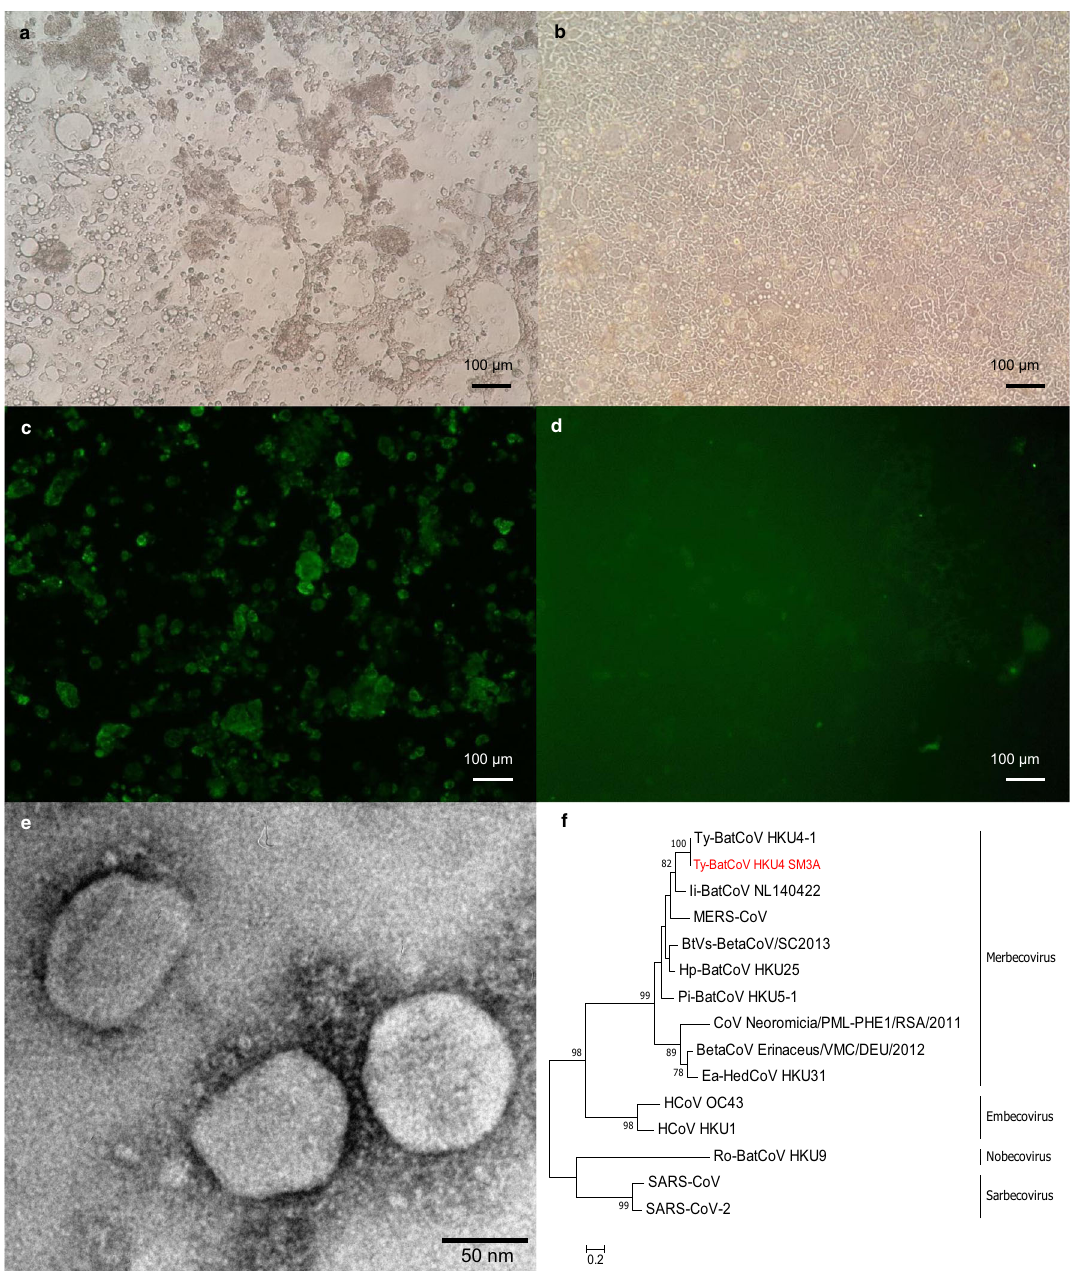
Fig. 1 Isolation of Ty -BatCoV HKU4 using Caco-2 cells. a Caco-2 cells infected with Ty -BatCoV HKU4 SM3A showing CPE with rounding up of fused and granulated cells progressively detaching from the monolayer forming masses of dead cells at 5 dpi, compared to b uninfected cells. c IF staining of Caco-2 cells infected with Ty -BatCoV HKU4 SM3A, compared to d uninfected cells using mouse antiserum against N. Scale bars, 100 μ m. e Ty -BatCoV HKU4 SM3A viral particles under transmission electronic scope. Viral particles, size about 100 – 120 nm, were visualized, showing spikes around the particles typical of coronavirus. Scale bar, 50 nm. Images are representative of three independent experiments. f Phylogenetic analysis of S1 amino acid (aa) sequences of Ty -BatCoV HKU4 SM3A (red in color) and other selected showed that MERS-RBD can pull down hDPP4 and dcDPP4 but not Tp DPP4, whereas HKU4-RBD can pull down all three DPP4 receptor proteins (Fig. 3b). SPR assays using Biacore X100 showed that MERS-RBD and HKU4-RBD bound to hDPP4 with an equilibrium dissociation constant ( K d ) of 631.7 nM and 1.103 µM, respectively, suggesting stronger binding between MERS-RBD and hDPP4 by two-fold. MERS-RBD and HKU4- RBD bound to dcDPP4 with K d of >18.68 and >47.66 µM, respectively, suggesting weaker binding than to hDPP4. MERS- RBD and HKU4-RBD bound to Tp DPP4 with K d of 0.7 M and